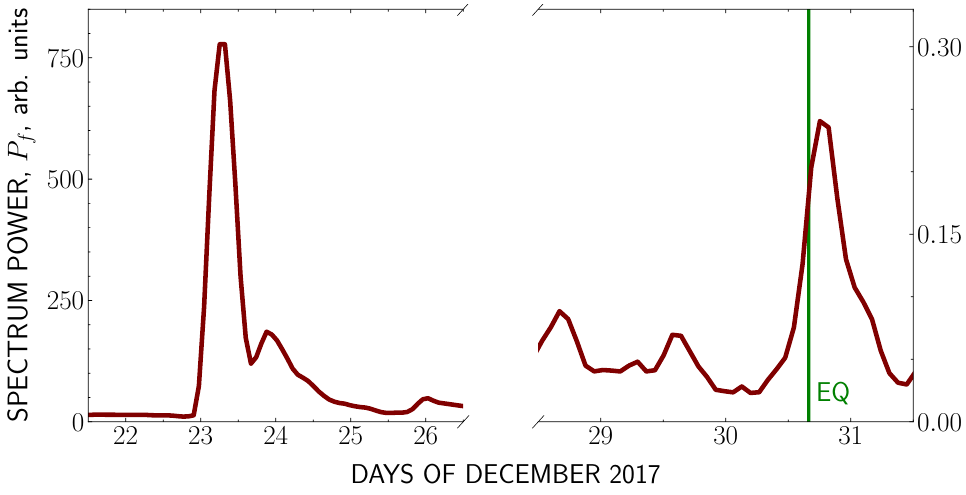
Figure 8. The dynamic power spectrum of the gamma ray flux measured a few days before and after the 30 December 2017 earthquake. The vertical line marks the moment of the earthquake